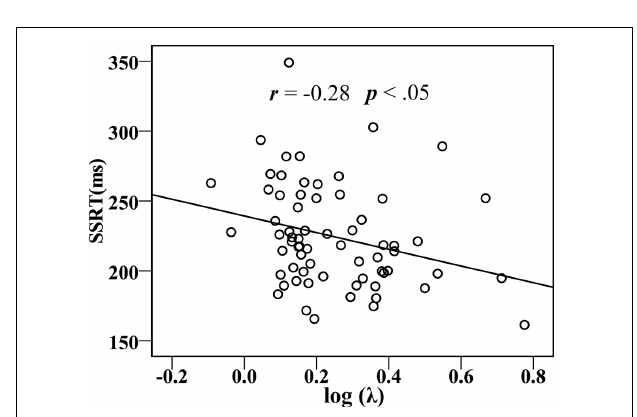
FIGURE 4 | Correlations between the SSRT and behavioral or the ratio of win/loss in risky gables (log λ